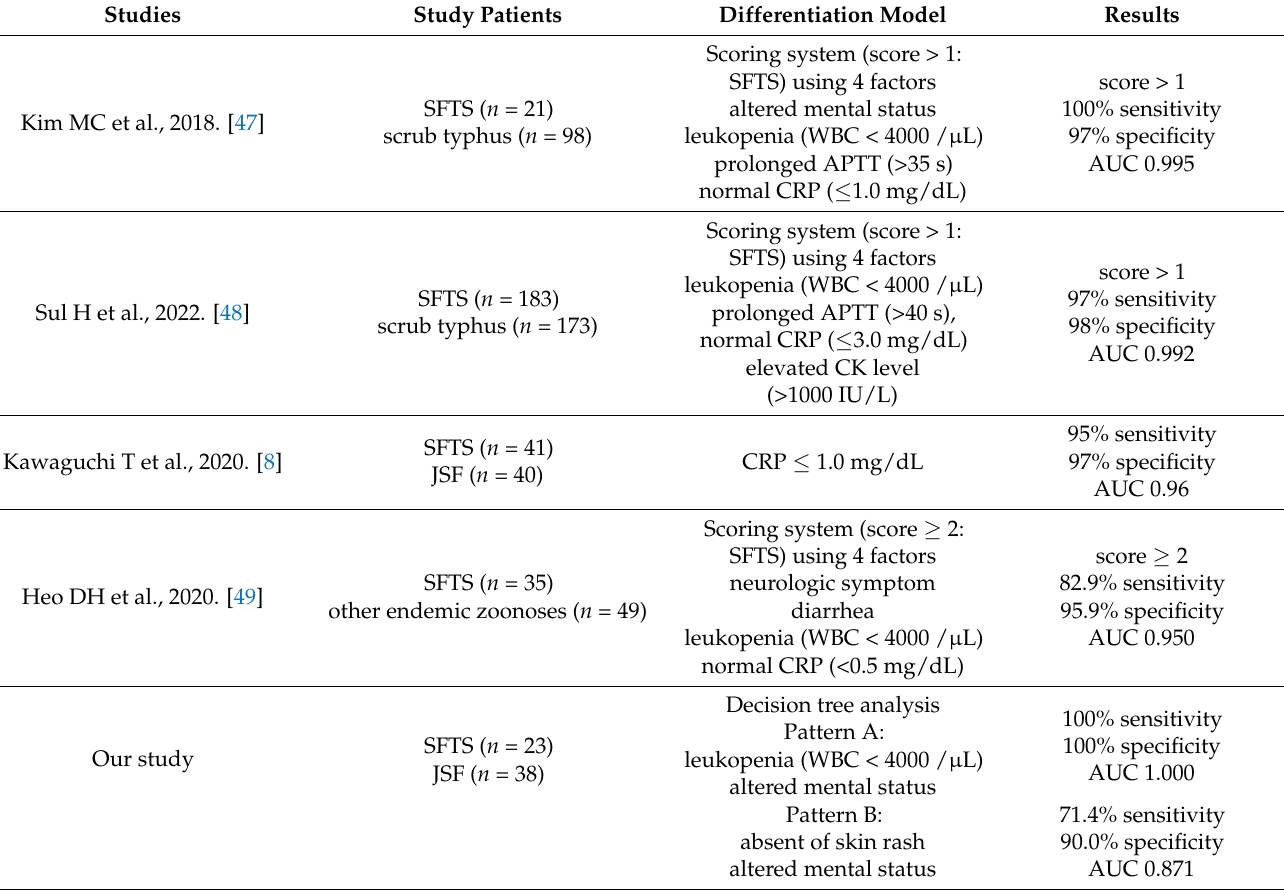
Table 6. Comparison of studies to differentiate SFTS from other zoonoses including